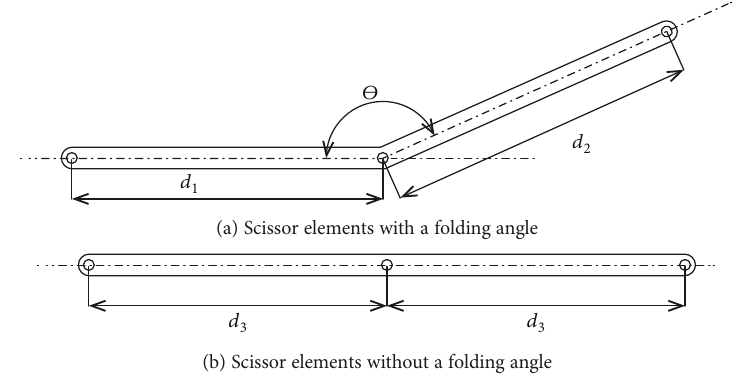
Figure 4: Basic component of scissor elements.